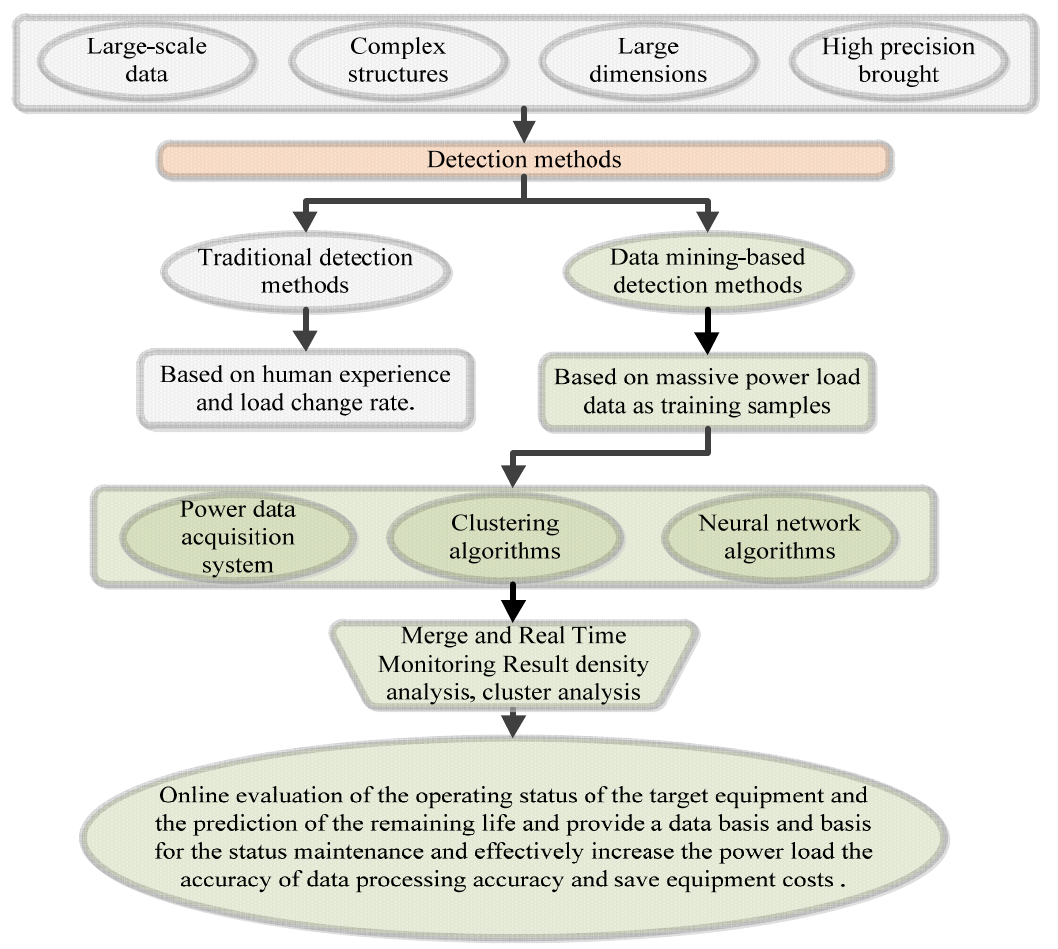
Figure 4. Techniques power system detection.